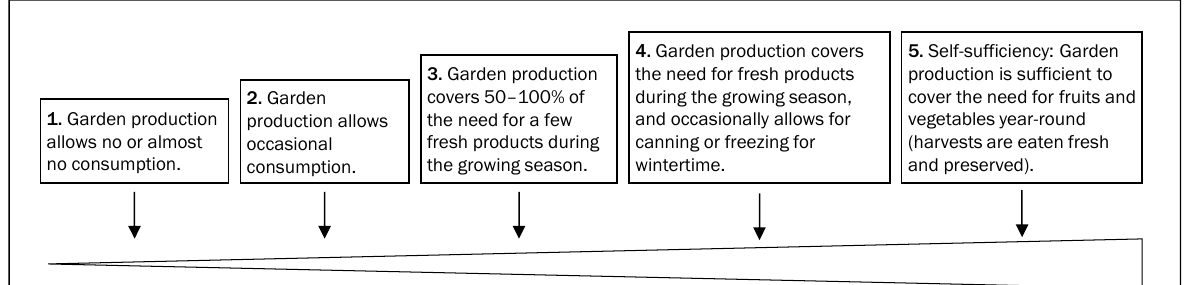
Figure 3. Gradient of Collective Garden’s Contribution to the Gardener’s Food